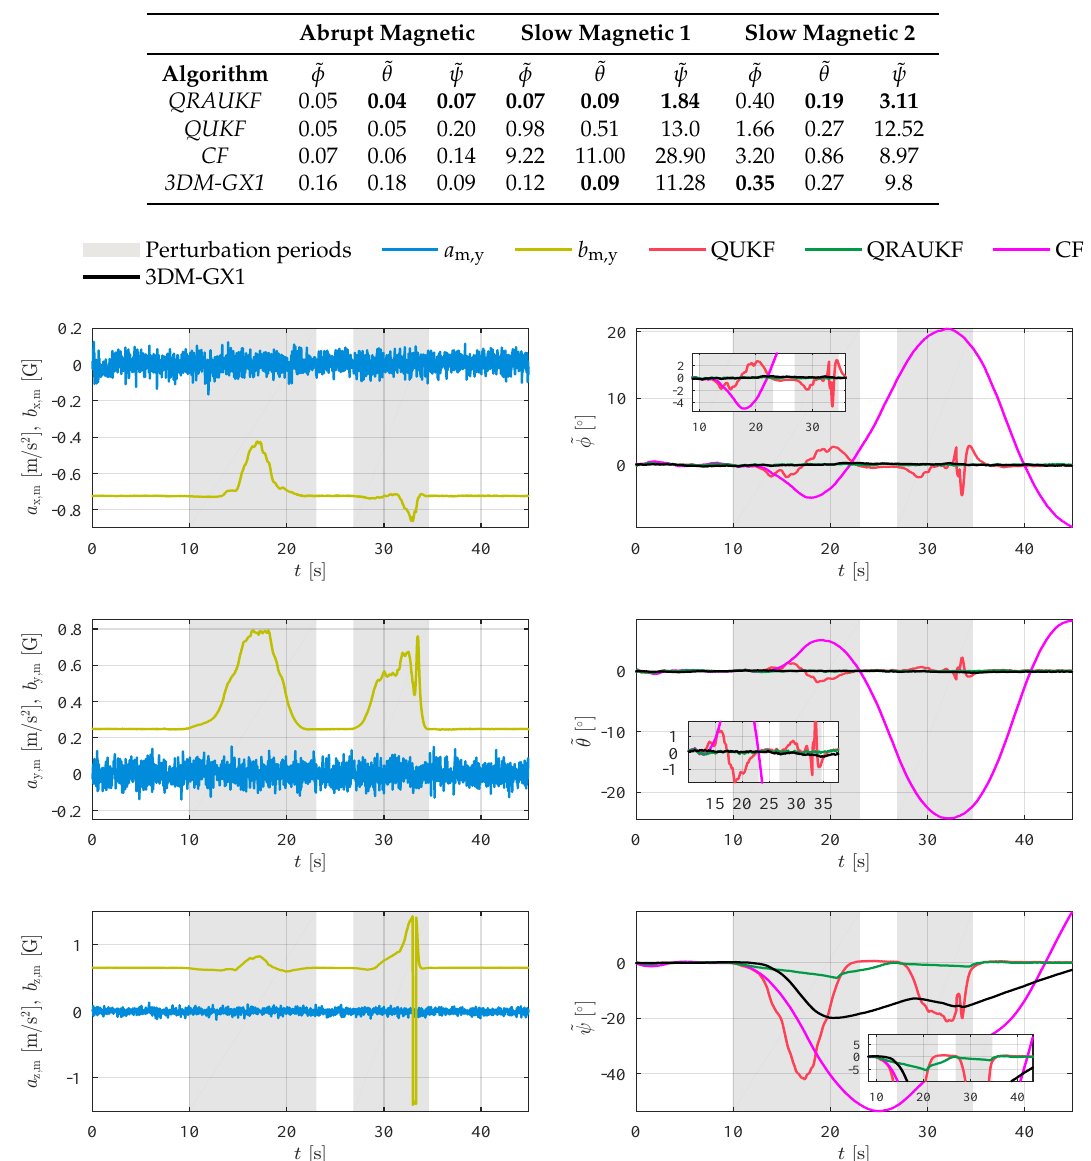
Table 1. Root Mean Square Error (RMSE) in degrees for disturbance scenarios (i) and (ii). The lowest RMSE results are highlighted in bold.